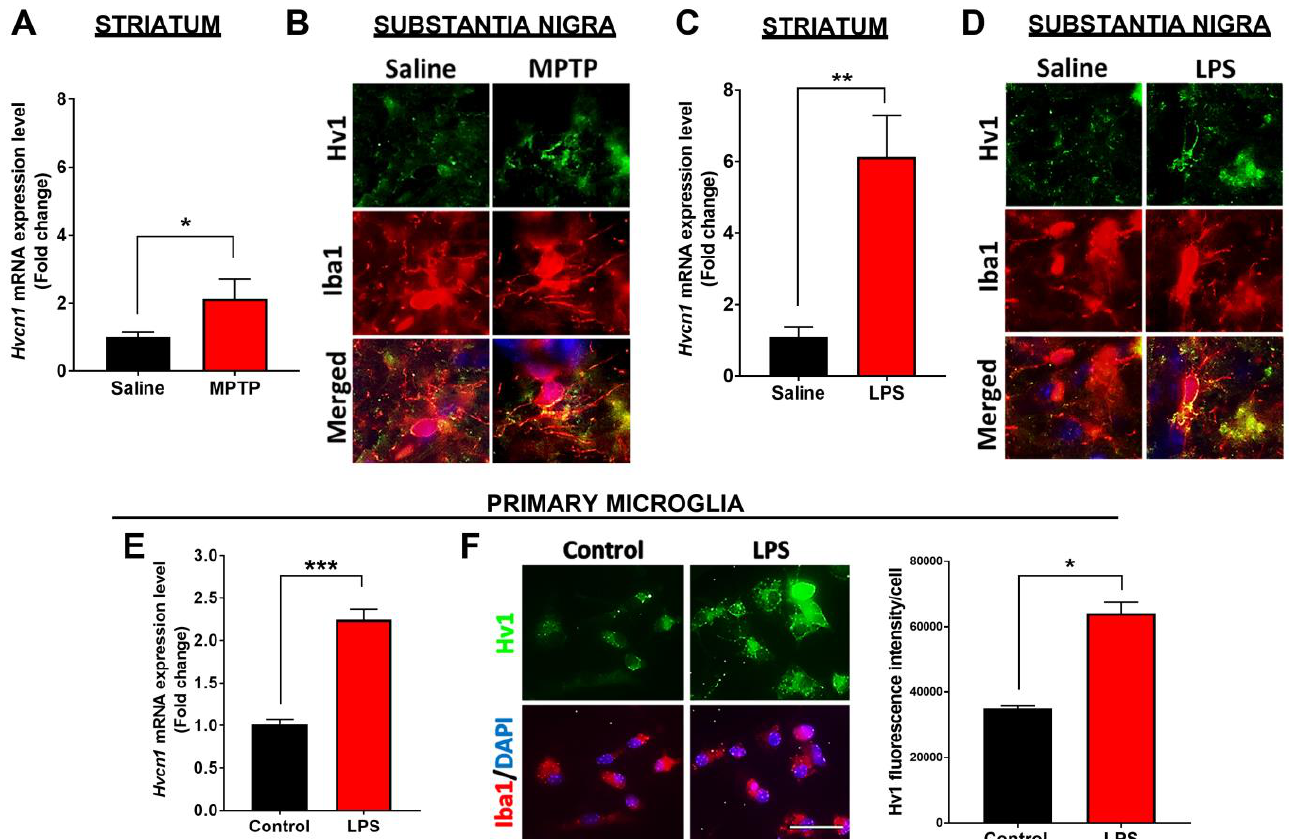
Figure 2. Increased Hv1 levels in the brain of neurotoxic animal models of PD and LPS-treated primary microglia. ( A ) mRNA levels of Hvcn1 in the striatum of acute MPTP (4 × 10 mg/kg) or saline-treated C57BL/6J mice. ( B ) Representative immunofluorescent images of Hv1 (green) protein level in Iba1-positive (red) cells in SN of saline and MPTP treated C57BL/6J mice, scale bar 5 µm. ( C ) Quantitative PCR mRNA expression levels of Hv1 in the C57BL/6J mouse striatum following sub- chronic LPS treatment. ( D ) Representative immunofluorescent images of Hv1 protein levels in Iba1- positive cells in the SN of C57BL/6J mice following saline or LPS treatment, scale bar 5 µm. ( E , F ) C57BL/6J primary microglia treated with LPS increase Hv1 mRNA and protein levels, measured by qPCR ( E ) and quantified immunofluorescent images ( F ); scale bar 20 µm. n = 4 – 5 mice per group and 3 isolations for primary microglia. Asterisks denote statistically significant differences — * p < 0.05, ** p < 0.01, *** p < 0.001, using unpaired Student’s t -test. Error bars denote the standard error of the mean. 3.2. Hv1 KO Mice Have Lower Basal Inflammatory Status and Exhibit a Reduced MPTP- Mediated Inflammatory Response in the Mouse Nigrostriatal Pathway Because Hv1 is mainly expressed in microglia, we investigated the inflammatory sta- tus of Hv1 KO striatum compared to WT mice under basal conditions. We found that Hv1 KO mice had reduced basal gene expression of pro-inflammatory factors ( Gp91phox , Tnfα , Il-6 , Ifnγ , Nos2 , and Il- 1β ), with increased gene expression of each anti-inflammatory factor measured ( Arginase-1 , Mrc1 , Igf-1, Ym1, and Nrf2) (Figure 3A). The significant increase in Arginase-1 and Ym1 expression indicates that Hv1 KO mice may have higher basal anti- inflammatory alternatively activated microglia, also termed M2, in the striatum. Next, we determined whether Hv1 KO could alter the MPTP-induced generation of ROS and nitric oxide (NO). We measured the mRNA levels of iNOS (encoded by the gene Nos2 ), the en- zyme responsible for generating NO, and Gp91phox , a component of the NADPH oxidase system responsible for generating ROS. MPTP treatment in WT mice significantly in- creased the mRNA levels of these two genes by 2-fold compared to controls. Hv1 defi- ciency completely blocked this MPTP-induced upregulation (Figure 3B). We further